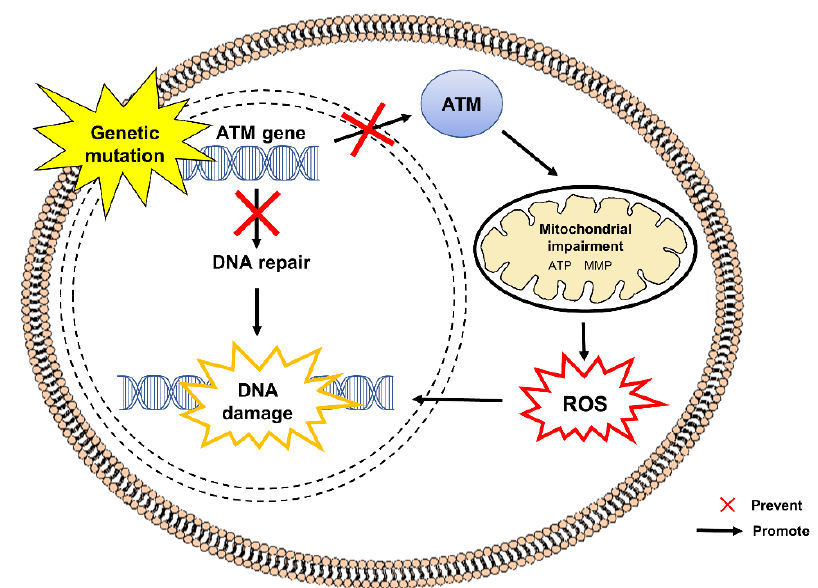
Figure 1. Mutation in the ATM gene in the pathogenesis of A-T. The defective ATM gene results in the disruption of DNA repair mechanisms that are critical for maintaining the integrity of genomic DNA and subsequent accumulation of unregulated DNA damage. An absence or deficiency of ATM protein contributes to the impairment of mitochondria, leading to excessive production of ROS. Dysregulated ROS signaling further accelerates DNA damage. ATM, ataxia-telangiectasia mutated; ATP, adenosine triphosphate; DNA, deoxyribonucleic acid; MMP, mitochondrial membrane poten- tial; ROS, reactive oxygen species.